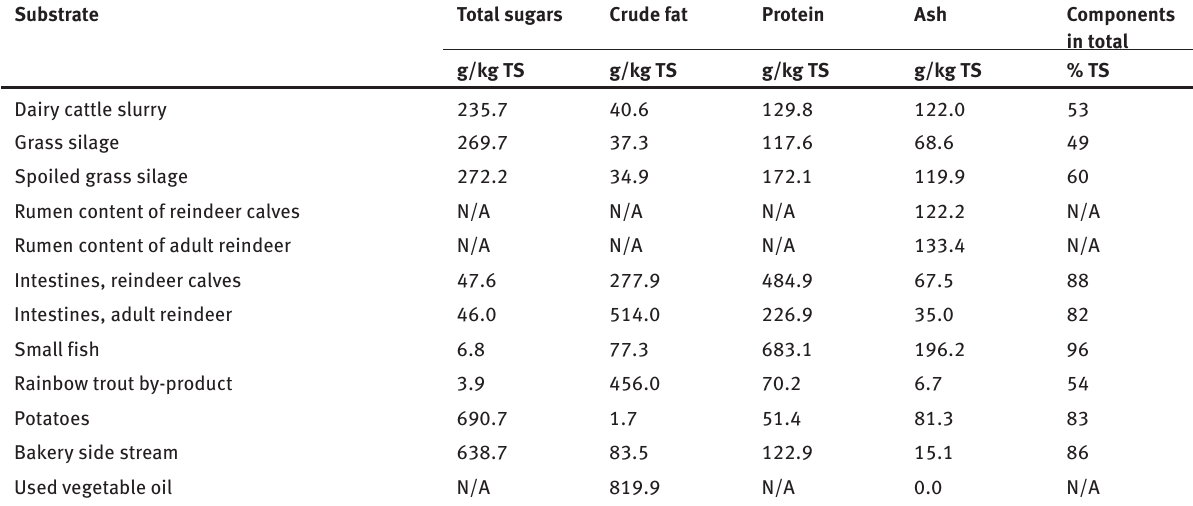
Table 3 : Chemical composition of substrates (g/kg TS) and the sum of total sugars, crude fat, protein and ash (% TS basis) Substrate Total sugars Crude fat